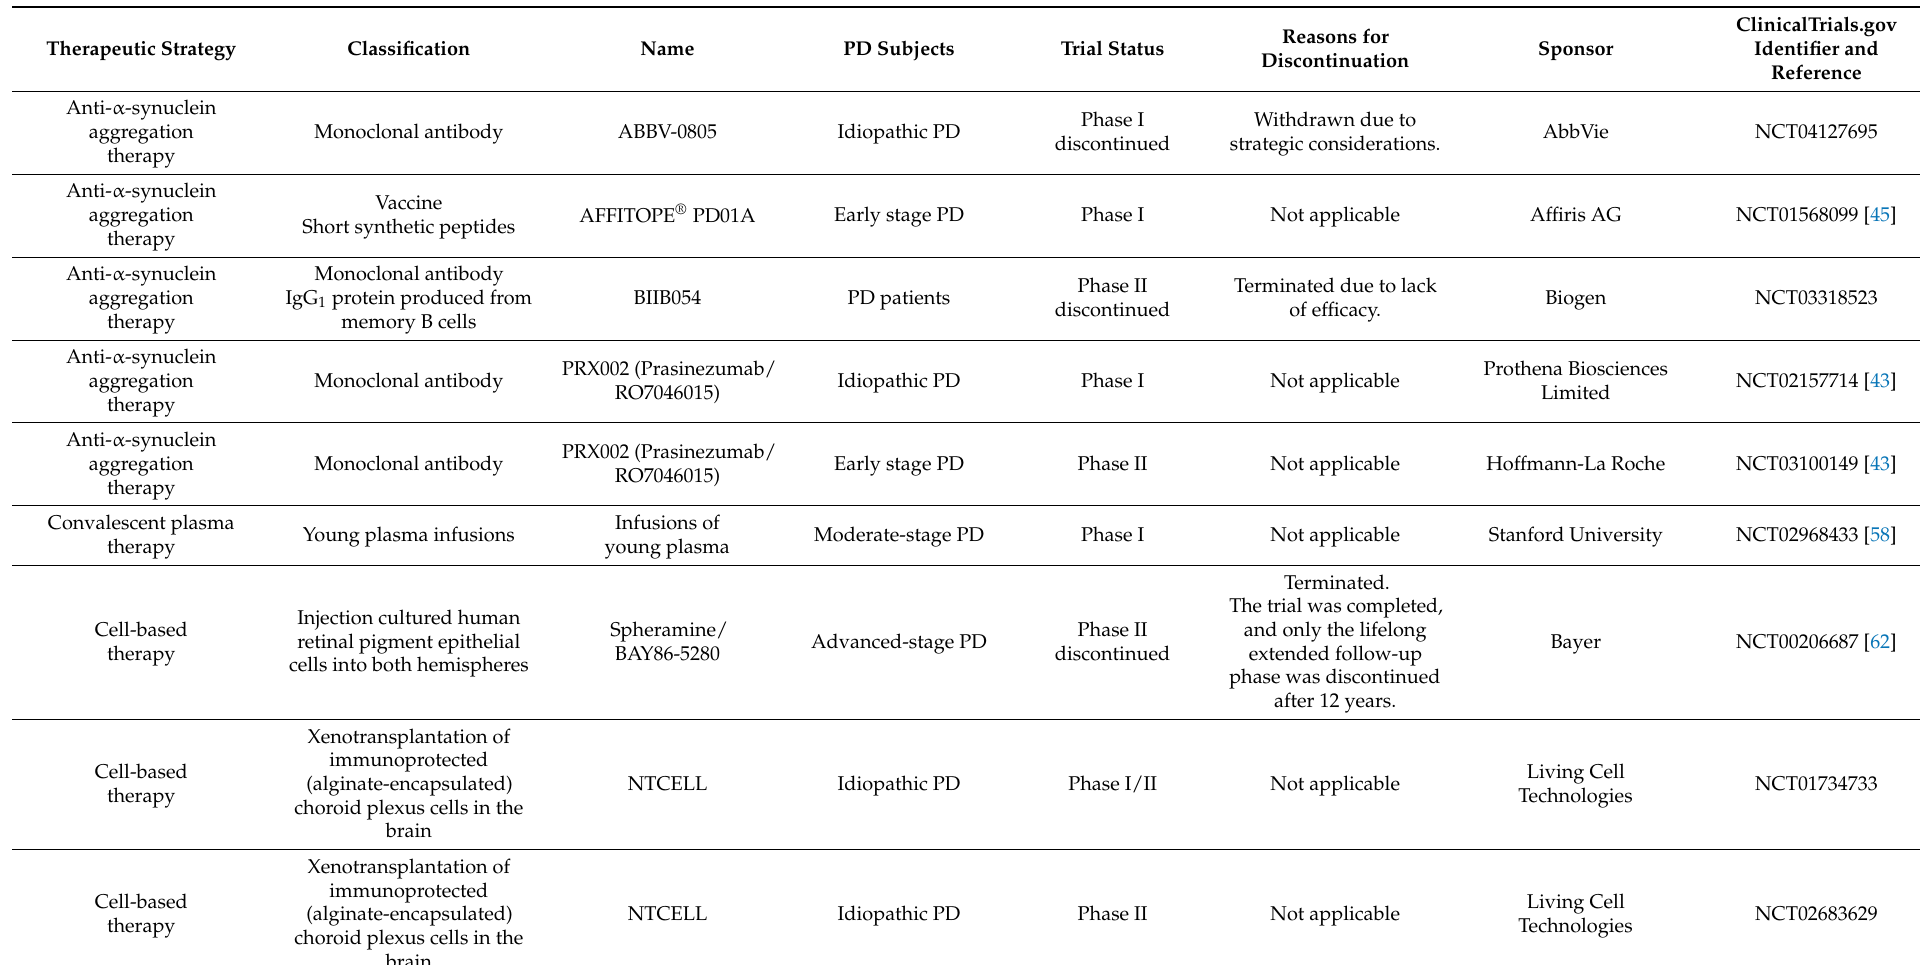
Table 2. Monoclonal antibodies and vaccines, plasma therapy, cell therapy, gene therapy, and herbal extracts in phase I, II, or III clinical trials for PD treatment. The data are based on the trial status (ongoing, updated, or discontinued) on ClinicalTrials.gov (https://clinicaltrials.gov) that is active as of 16 June